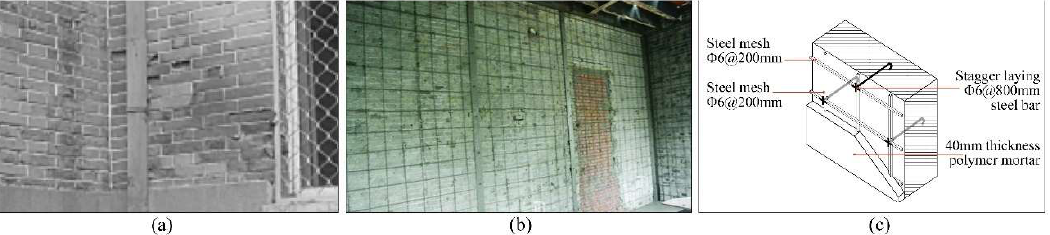
Figure 20. Wall strengthening (source: author). ( a ) Damaged exterior walls ( b ) Strengthening in progress ( c ) Wall strengthening methods